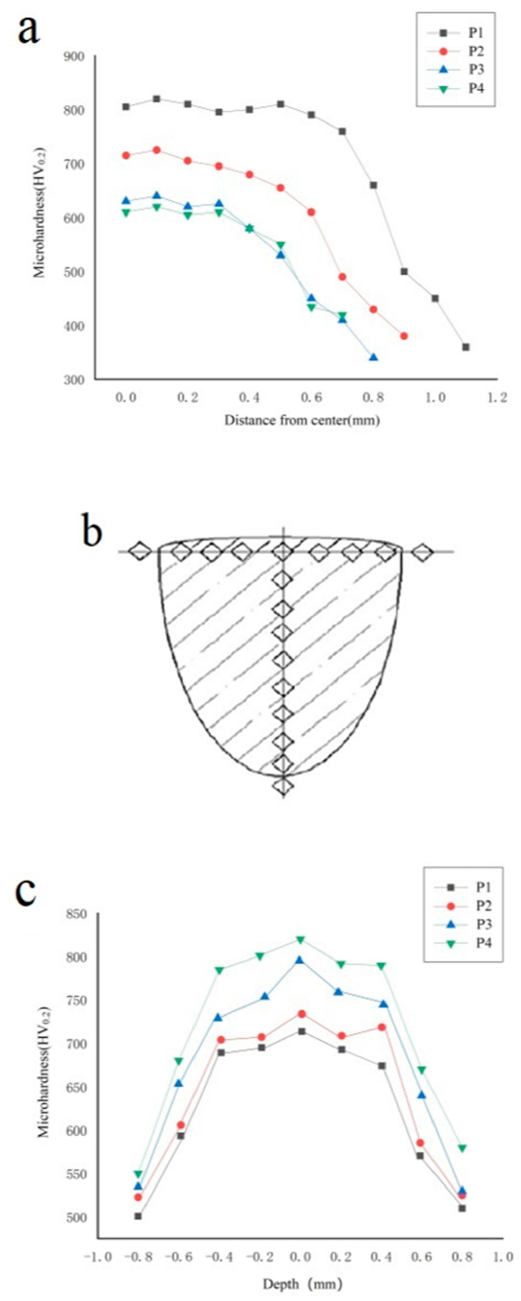
Figure 10. Distribution of microhardness in transverse and longitudinal direction of unit. ( a ) Hardness of unit in transverse direction ( b ) Hardness distribution of unit ( c ) Depth hardness distribution of unit.